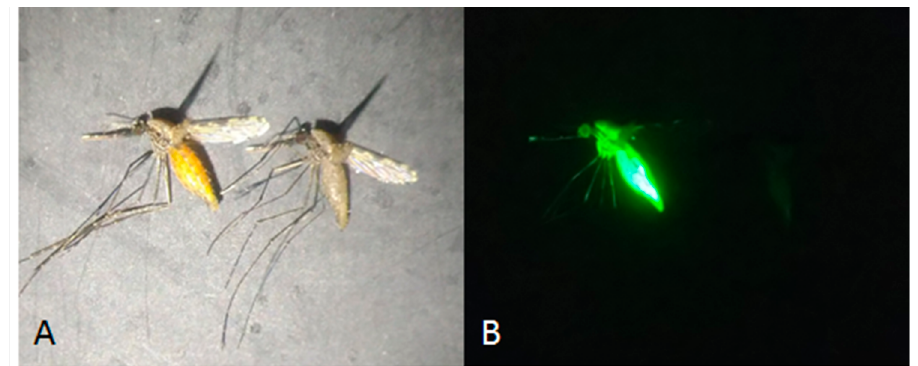
Figure 1. Sugar feeder made from a plastic pot of 2.5 cm height, large radius of 4.5 cm, and small radius of 4 cm. A wad of cotton wool was pressed into the pot to be just below the upper lip without touching the netting (judged by eye) and soaked in sugar solution into which the required concen- tration of insecticide was dissolved. A double layer of netting was stretched across the top and se- cured using an elastic band.